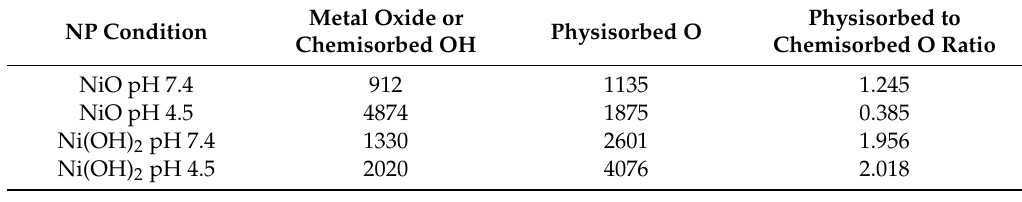
Table 2. Relative number of binding sites from integrated X-ray photoelectron spectroscopy (XPS) O 1s peak areas.